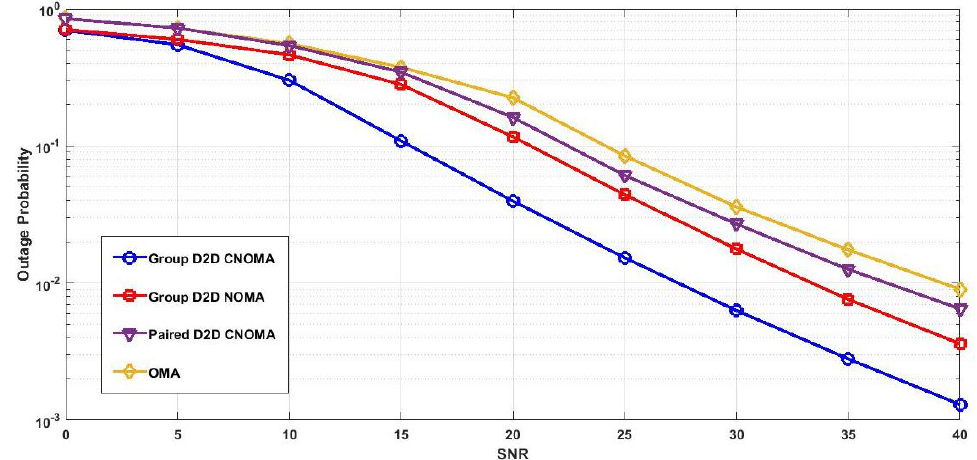
Figure 2. Outage probability comparison of proposed Q-CNOMA with C-NOMA, Q-NOMA, NOMA and